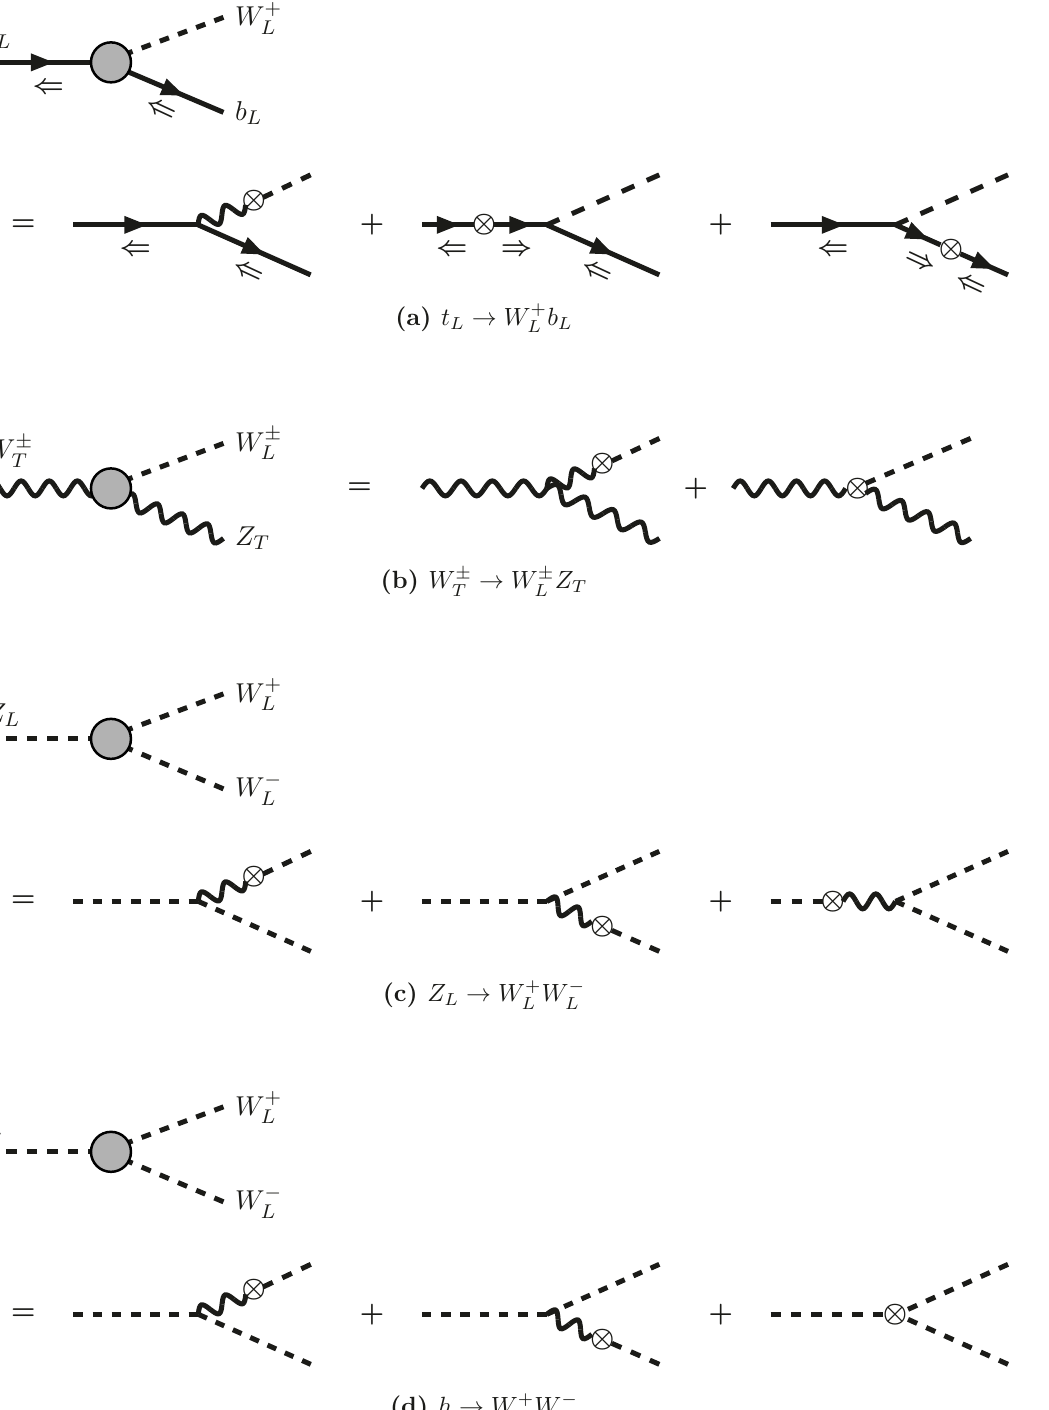
Figure 13. Representative ultra-collinear splittings with multiple contributing diagrams. The effects of the VEV are indicated schematically by the symbol